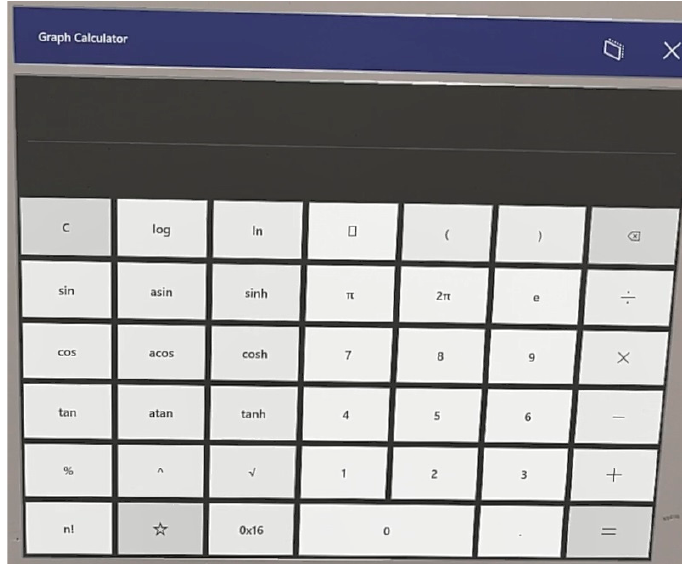
Figure 1. Virtual calculator panel.